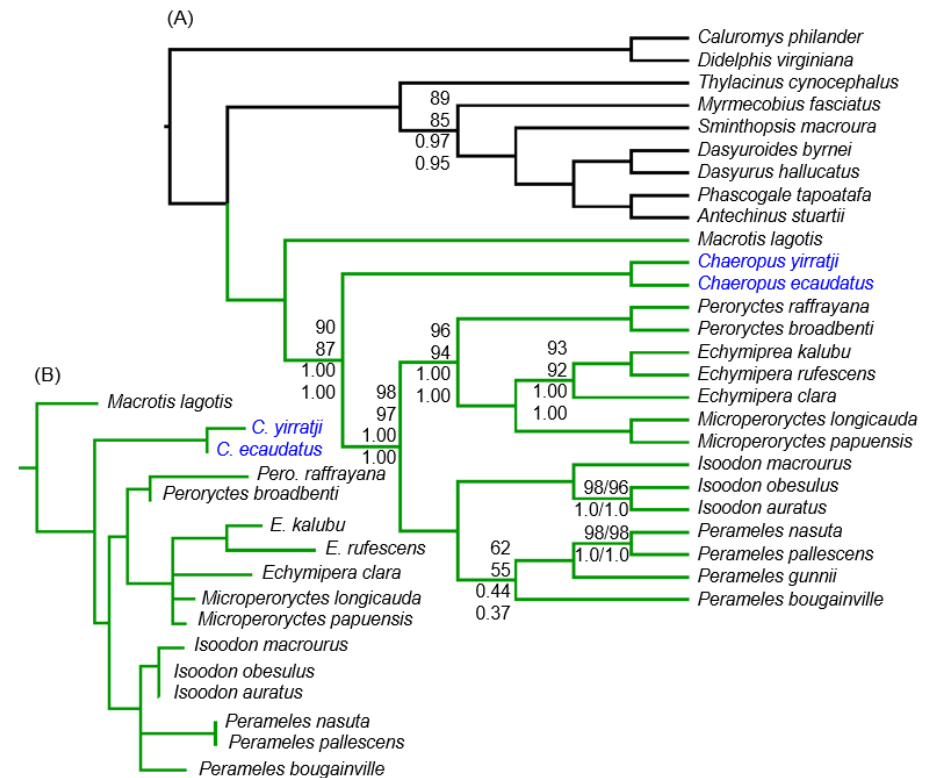
Figure 4. ( A ) MtNuc 26 maximum likelihood phylogeny focusing on Peramelemorphia (bandicoots and bilby, green branches) and without phylogenetic constraints. Clade support values at nodes,